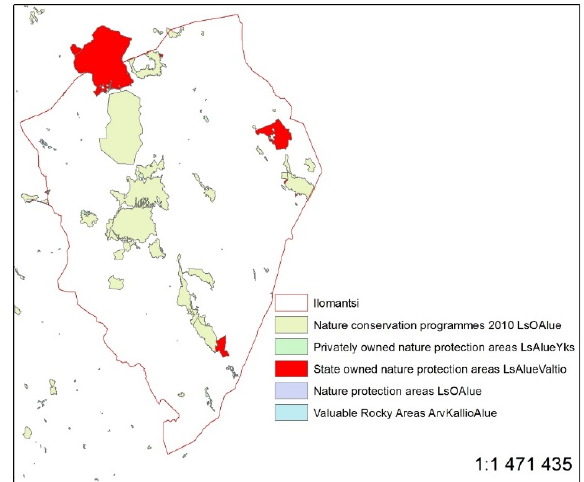
Figure 2. GIS layers of nature protection areas of the Ilomantsi commune from the OIVA database.